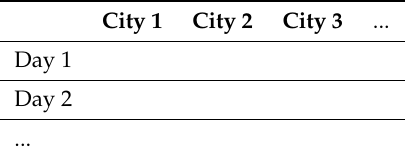
Table 1. Explanation of the distribution fitting